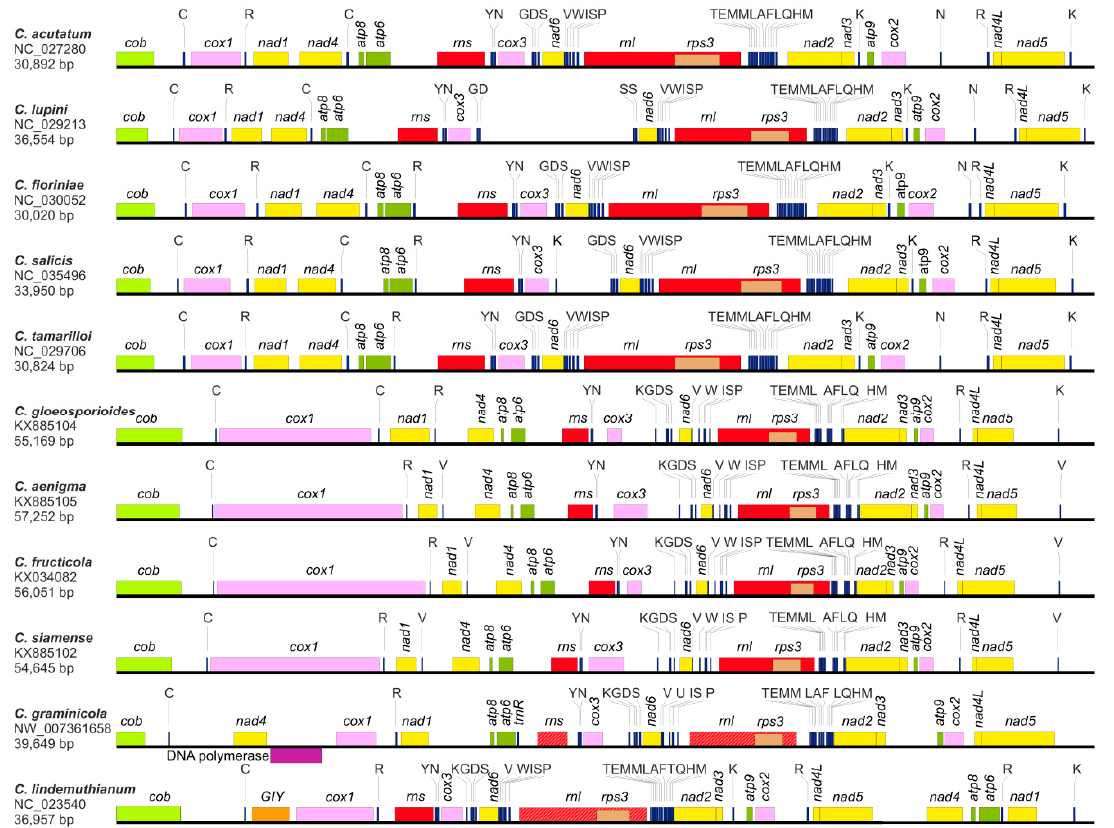
Figure 1. Linear maps of the mitochondrial genomes of 11 Colletotrichuim species. All genes, excluding DNA polymerase in the C. graminicola mt genome, are encoded on the same strand. Standard nomenclature was applied for protein and rRNA genes, whereas for tRNA genes, single-letter abbreviations were used. The presented maps include updated genome annotation data for C. graminicola, and C. lindemuthianum (striped bars for rns and rnl ).